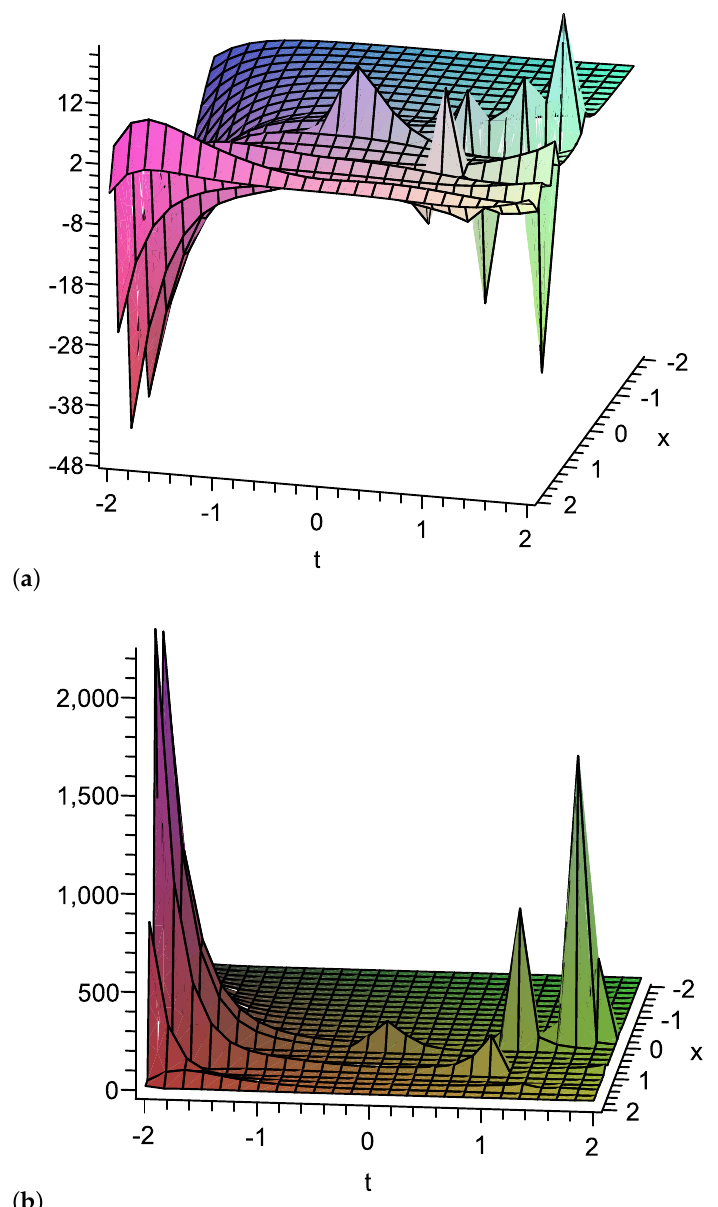
Figure 3. The first and second moments for the random solution sq 5 in (51); α is a beta random variable and − 2 ≤ t , x ≤